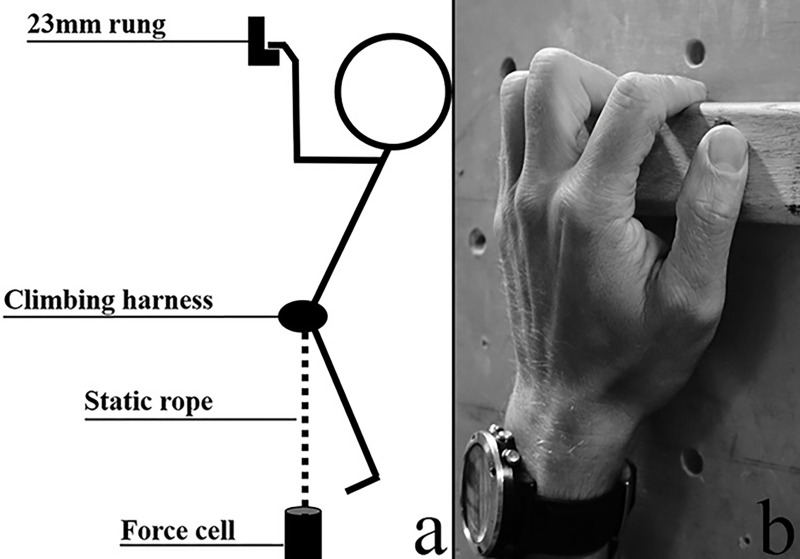
Illustration showing a) the test set-up for the isometric pull up and b) the half crimp grip on the 23mm rung.